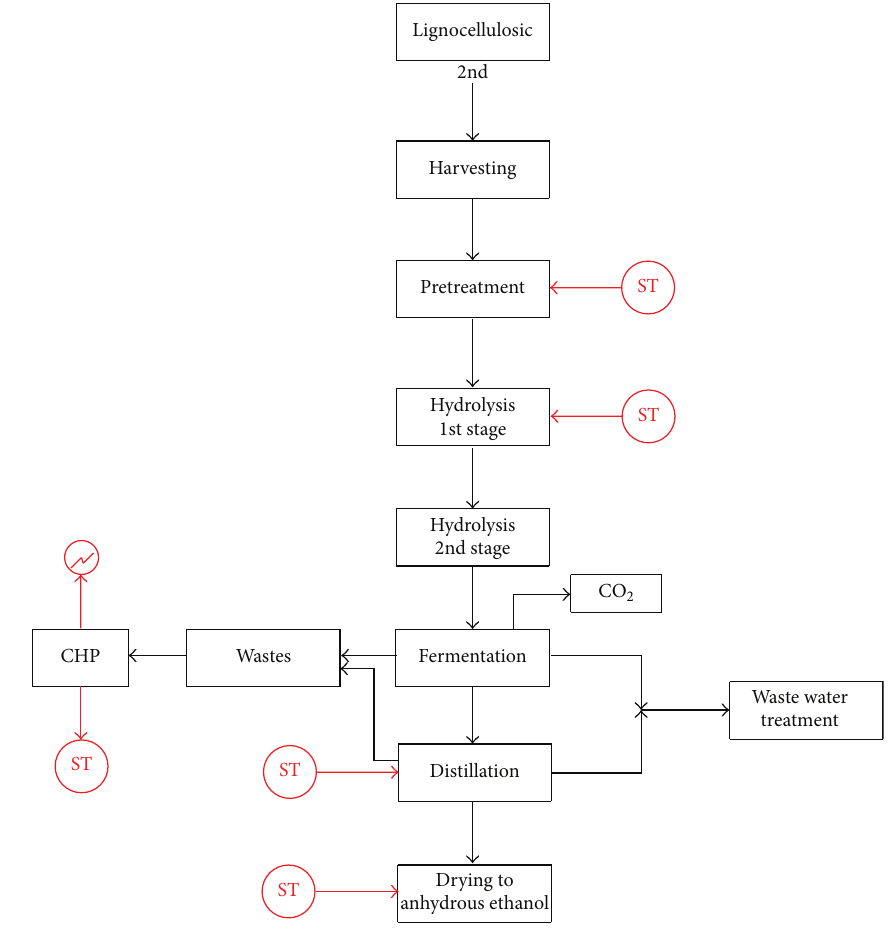
Figure 1: Second generation biomass-to-ethanol production (ST: steam